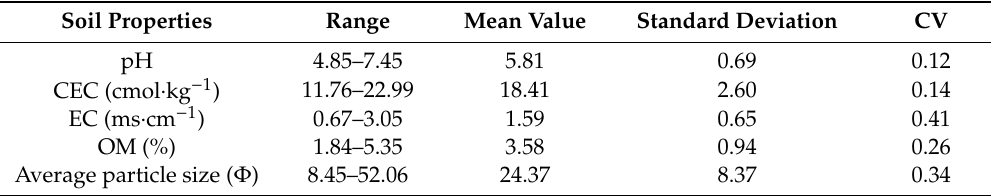
Table 3. Soil properties including pH, cation exchange capacity (CEC), electrical conductivity (EC), organic matter (OM), and particle